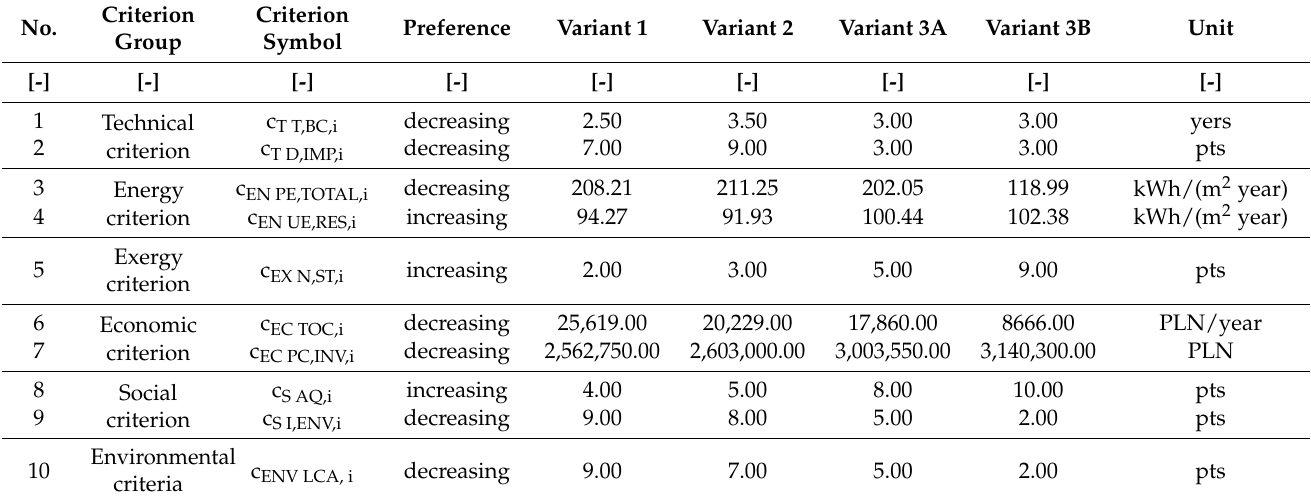
Table 6. Numerical values of indicators and their preferences for the adopted evaluation criteria.